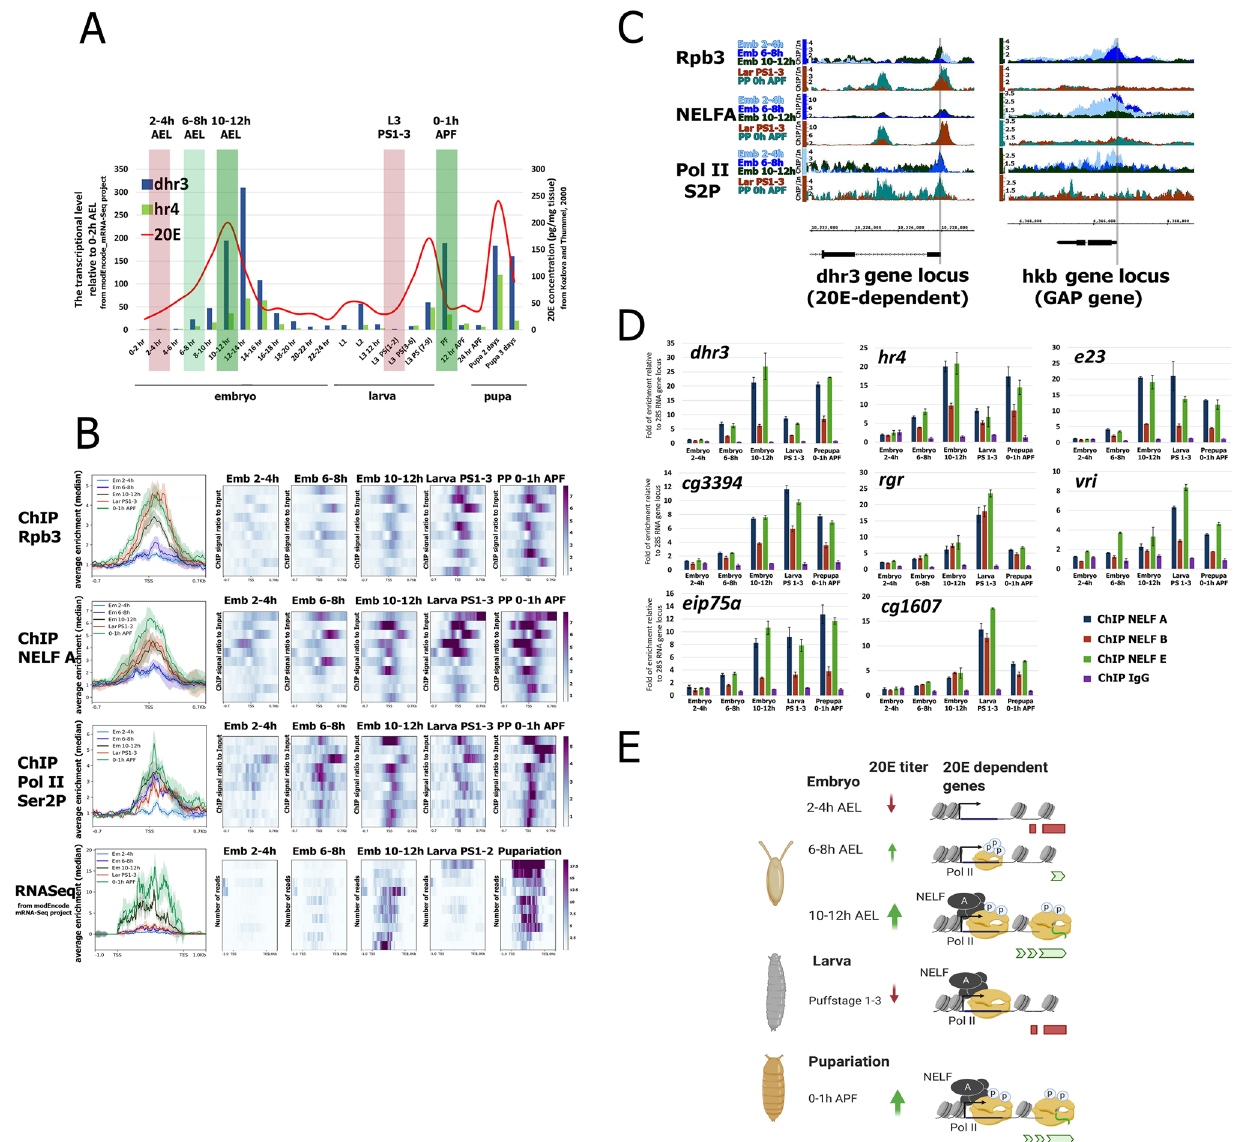
Figure 4. NELF organizes Pol II pause on 20E-dependent promoters during larva-to-pupa transition. ( A ) The transcription levels of dhr3 (blue columns) and hr4 (green columns) 20E-dependent genes during ontogenesis of Drosophila (from modENCODE_mRNA- Seq data 30 ) relative to their transcription during 0–2 h after egg laying (AEL) (Y axis on the left of the figure). Purple and green transparent lines indicate the investigated developmental stages (2–4 h AEL, 6–8 h AEL, 10–12 h AEL, 3 rd stage larvae 12 h before pupariation (L3 PS1-3), 0–1 h after puparium formation (APF)). Red line indicates an average 20E concentration in the tissues (Y axis on the right) during Drosophila development (according to ref. 35 ). ( B ) Average distribution of Rbp3, NELF-A and Pol II Ser2P binding on stably induced 20E-dependent genes at different developmental stages. A set of stably induced 20E-dependent genes was selected from the list of genes induced in Drosophila S2 cells after 1-h treatment with 20E, based on a criterion—to demonstrate an increase in the transcriptional level both by 10–12 h AEL and during puparium formation (according to modENCODE_mRNA-Seq data 30 ). Protein binding levels were estimated by ChIP-Seq from corresponding developmental stage and calculated as an enrichment. Averaged RNA-seq profiles were calculated for 20E-dependent genes on different developmental stages, using the data from modENCODE_mRNA-Seq project 30 . Pile-up profiles were calculated as a median of Rbp3, NELF-A and Pol II Ser2P binding levels. The standard error is displayed on the graphs as lighter area around the main line of the profiles. ( C ) Binding profiles of Rpb3, NELF-A and Pol II S2P on dhr3 20E-inducible locus and on hkb locus (GAP gene) during Drosophila development. Protein binding levels were estimated by ChIP-Seq from corresponding developmental stage and calculated as an enrichment. Grey lines indicate the promoters. ( D ) ChIP analysis of NELF-A, NELF-B and NELF-E binding to promoters of some stably induced 20E-dependent genes at different developmental stages of Drosophila . The nuclear chromatin extracts were obtained from the same developmental stages as at ( B , C ) (indicated on the bottom of the histograms). Relative binding levels of NELF subunits were assessed by qRT-PCR. The Y-axis units represent the fold of enrichment relative to the control region (28S ribosomal RNA gene locus). ChIP with a serum of non-immunized rabbits (IgG) was used to assess the specificity of antibodies against NELF subunits. The data are mean values from three independent experiments, error bars represent standard deviations. ( E ) Proposed model of the changes in the state of 20E-stably induced promoters during Drosophila development (image created using